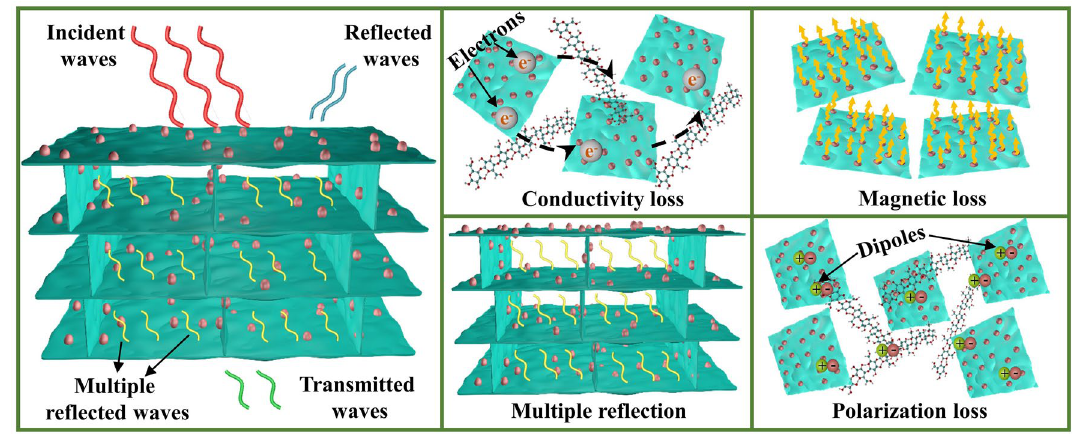
Fig. 5 Schematic illustration of EMI shielding mechanism for BTFCA/epoxy nanocomposites